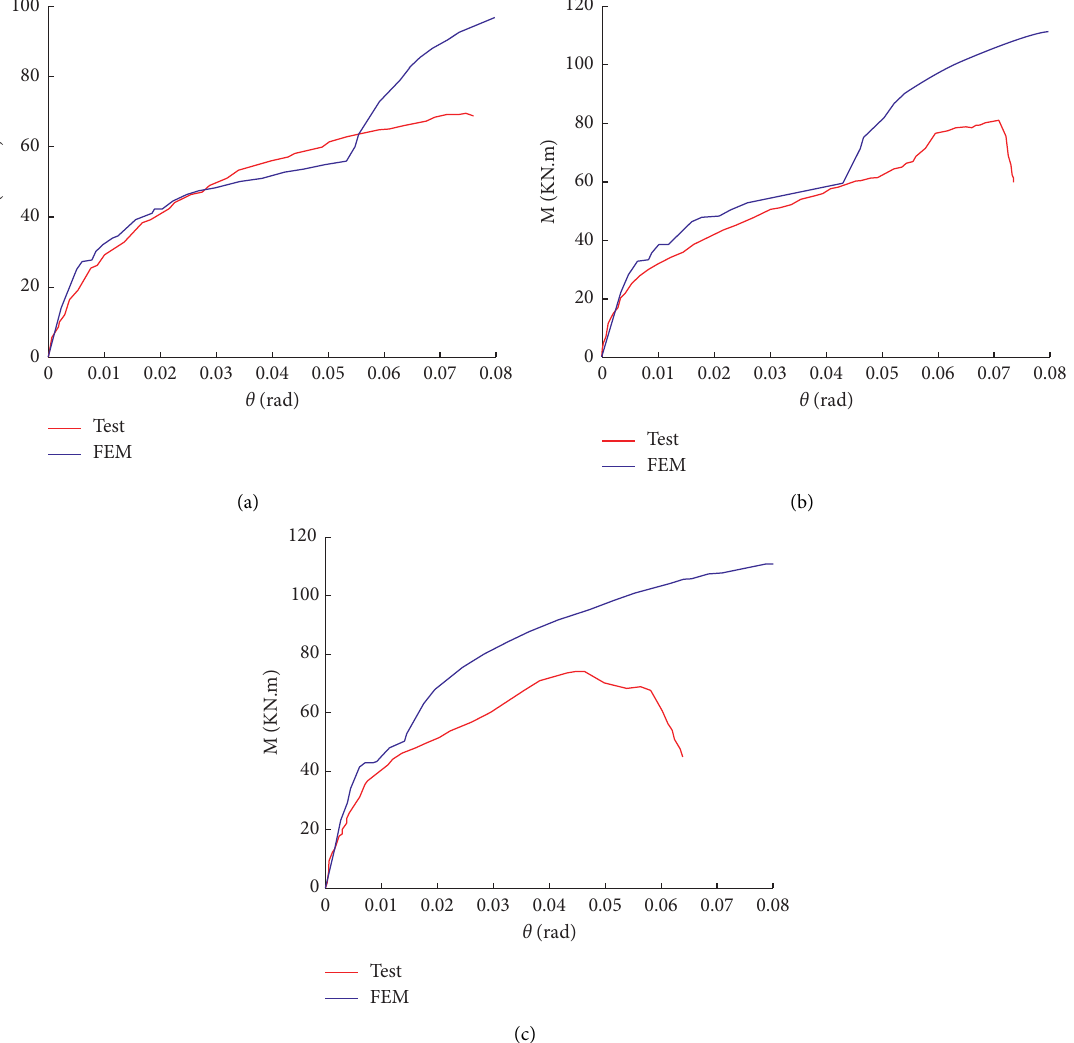
Figure 13: Comparisons of static loading tests and finite element simulations. (a) SJA-1. (b) SJA-2. (c)